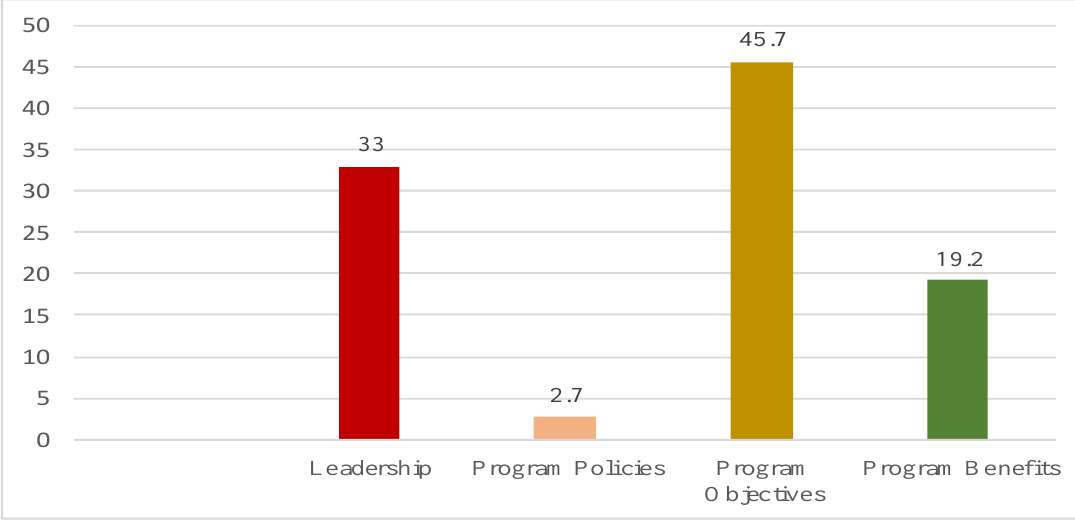
Figure 4: Institutional Determinants in Donor Fully Funded Development Programs Source: Field Survey,